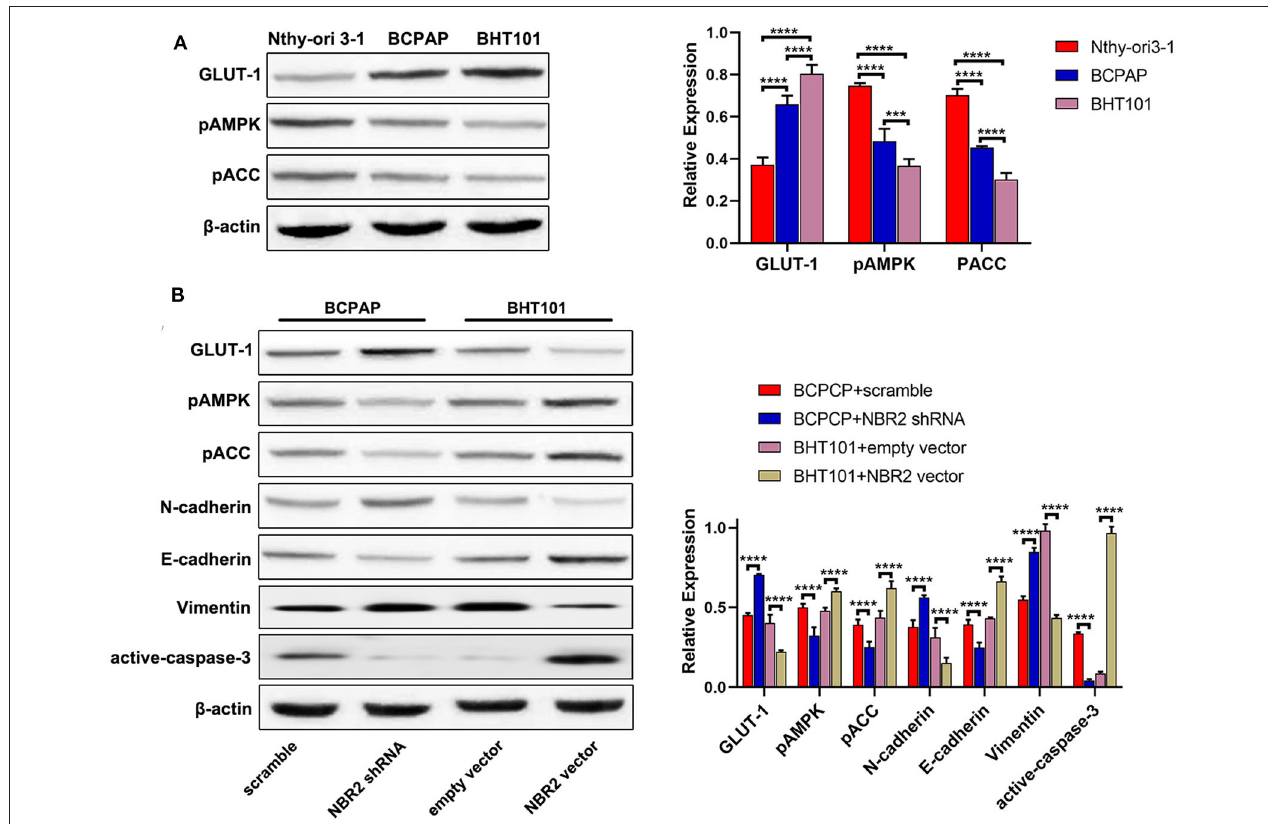
FIGURE 4 | Altered NBR2 expression changes the GLUT-1, E-cadherin, N-cadherin, Vimetin, and cleaved caspase-3 expression and AMPK and ACC phosphorylation in TC cells. (A) Western blot analysis of the expression of GLUT-1 expression and AMPK and ACC phosphorylation in Nthy-ori3-1, BCPAP, and BHT101 cells. (B) Western blot analysis of the levels of GLUT-1, E-cadherin, N-cadherin, Vimentin, and cleaved-caspase-3 expression and AMPK and ACC phosphorylation in TC cells. Data are representative images and expressed as the mean ± SD of each group of cells from three separate experiments. *** P < 0.005; **** P < 0.001.